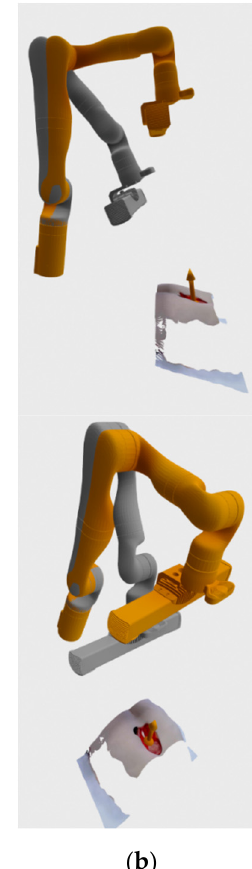
Figure 4. ( a ) Registered RGB-D image with bounding rectangle generated by the detection system; ( b ) 3D visualization of the current (grey) and requested (orange) robot position.